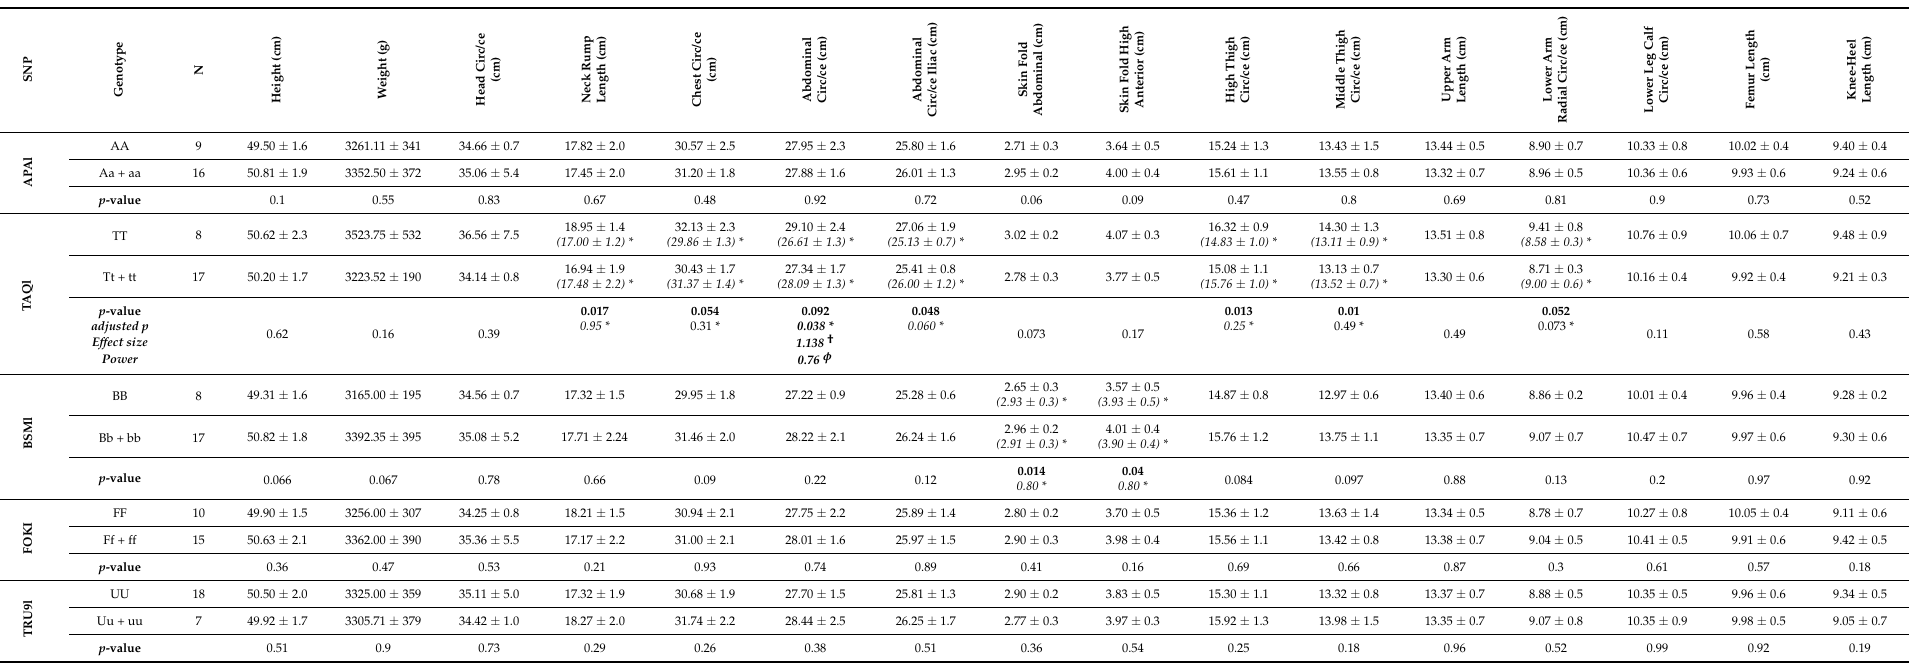
Table 3. Birth neonatal anthropometry (neonatal vitamin D status at birth <25 nmol/L), according to neonatal VDR polymorphisms.